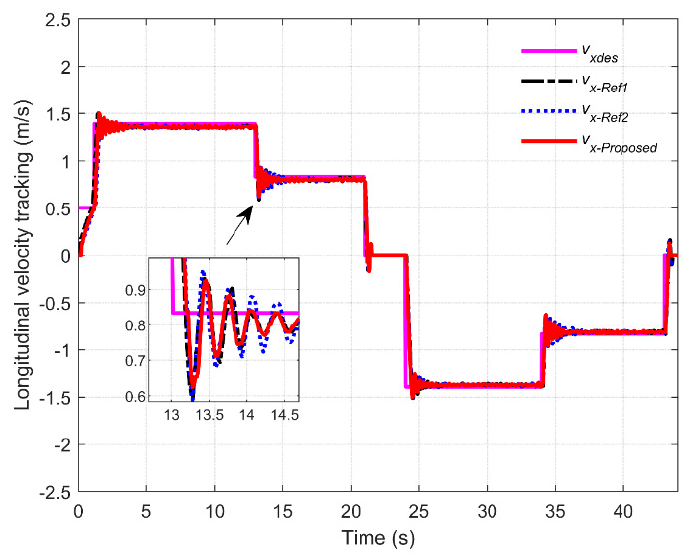
Figure 8. Longitudinal velocity tracking.